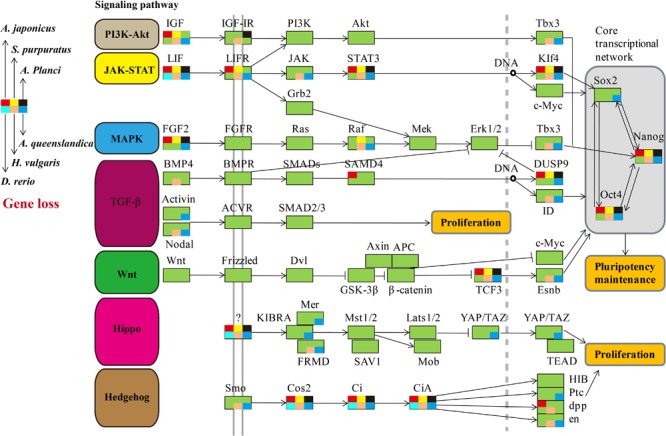
Comparative analysis of genes in regeneration-related signaling pathways of regenerative animals. The comparative analysis are performed on seven regeneration-related signaling pathways of six species. The genes present in genomes are markered in green background, and the genes absent in genomes are markered in other colors according to the legends.